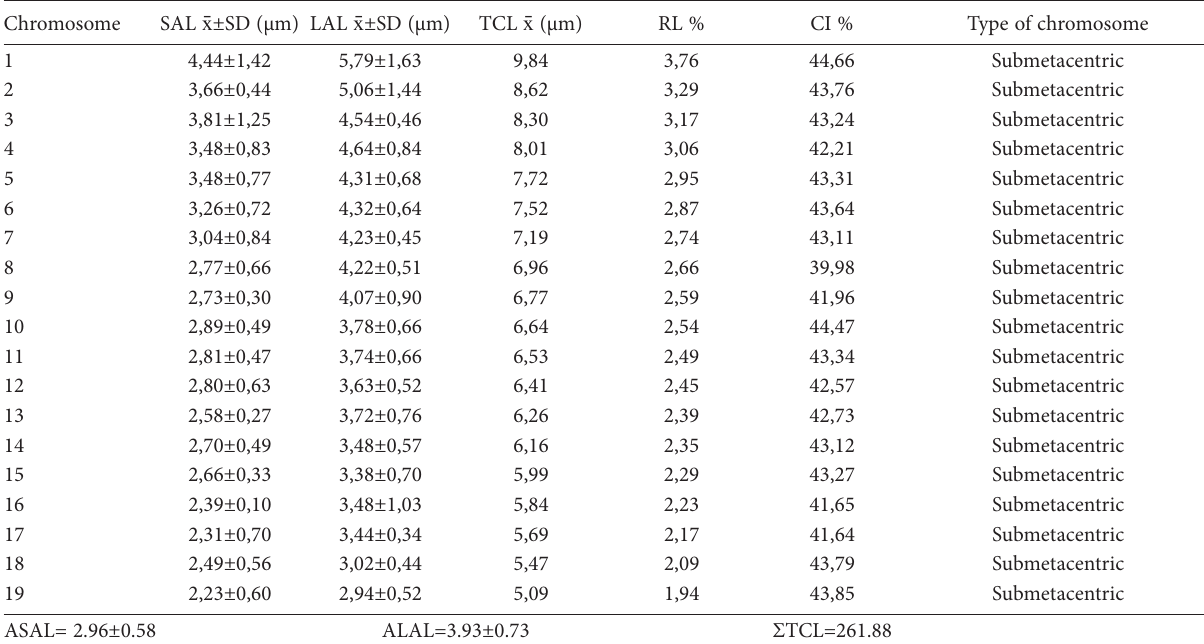
ASAL= 2.96±0.58 SD = Standard deviation, ASAL= average short arm, ALAL= average long